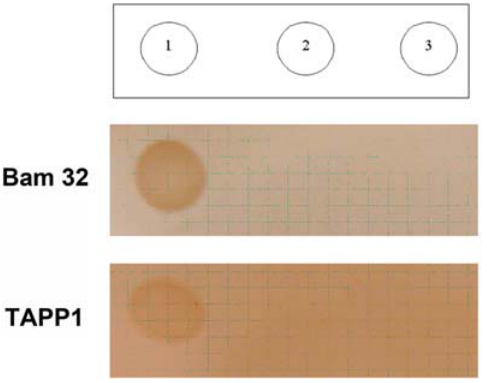
Figure 13 . Phosphoinositide binding properties of the amphioxus Bam32 and TAPP1. The ability of the following GST fusion proteins of amphioxus Bam32 and TAPP1 was analysed using a protein-lipid overlay. The indicated phosphoinositides (20 pmol) were spotted on to nitrocellulose membranes, which were then incubated with the purified GST-fusion proteins. The membrane was washed, and the GST-fusion proteins bound to the membrane by virtue of their interaction with lipid were detected using a GST antibody. A representative experiment of three is shown. The phosphoinositides are identified by the positions of encircled numbers at the top of the figure. 1, PtdIns (3, 4) P2; 2, PtdIns (3, 4, 5) P3; 3, PtdIns.